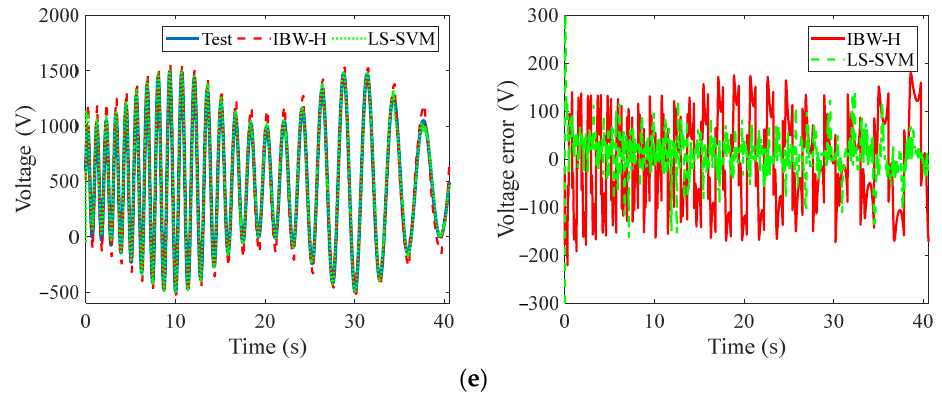
Figure 12. Feedforward voltage predictions of various signals based on hysteresis compensation models of LS-SVM and inverse model of BW-H: ( a ) 0.25 Hz, ( b ) 0.5 Hz, ( c ) 1 Hz, ( d ) 0.25 Hz/0.5 Hz/1 Hz, and ( e ) variable frequency and amplitude. Table 2. Voltage prediction REs of various signals based on hysteresis compensation models of LS-SVM and inverse model of BW-H.